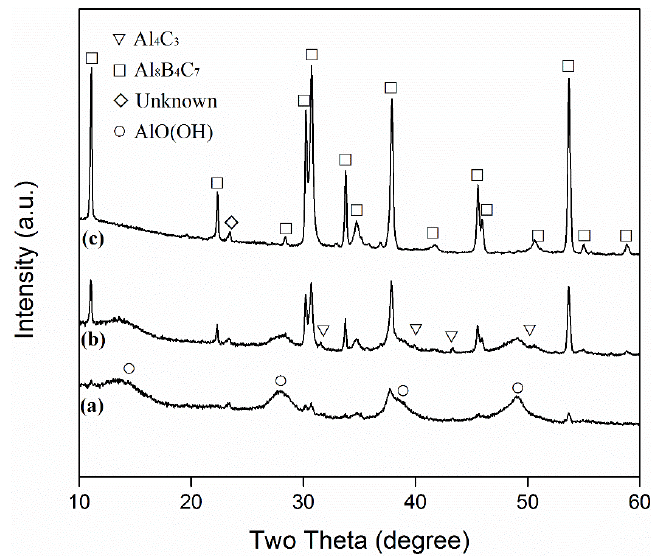
Figure 5. XRD patterns of samples resulting from 6 h of firing at 1250 °C in 20 g of ( a ) NaCl, ( b ) 97.5%NaCl+2.5%NaF, and ( c ) 95%NaCl + 5%NaF, respectively (after water washing).